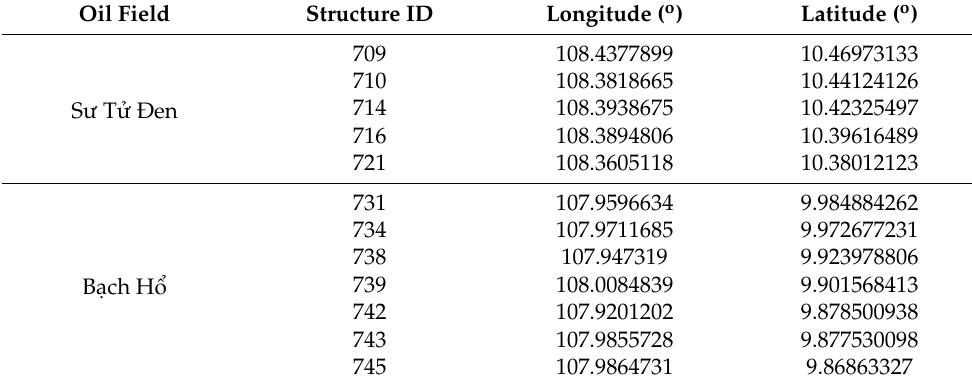
Figure 9. Detection of offshore structures (orange pixels inside circles) on the sea surface around ( a ) Bạch Hổ and ( b ) Sư Tử Đen oil fields. Each structure is assigned a unique identification (ID) number. Table 4. Centroid locations of structures including oil platforms or oil rigs around Bạch Hổ and Sư Tử Đen oil fields. The ID of the structures detected in the oil fields correspond to those in Figure 9.